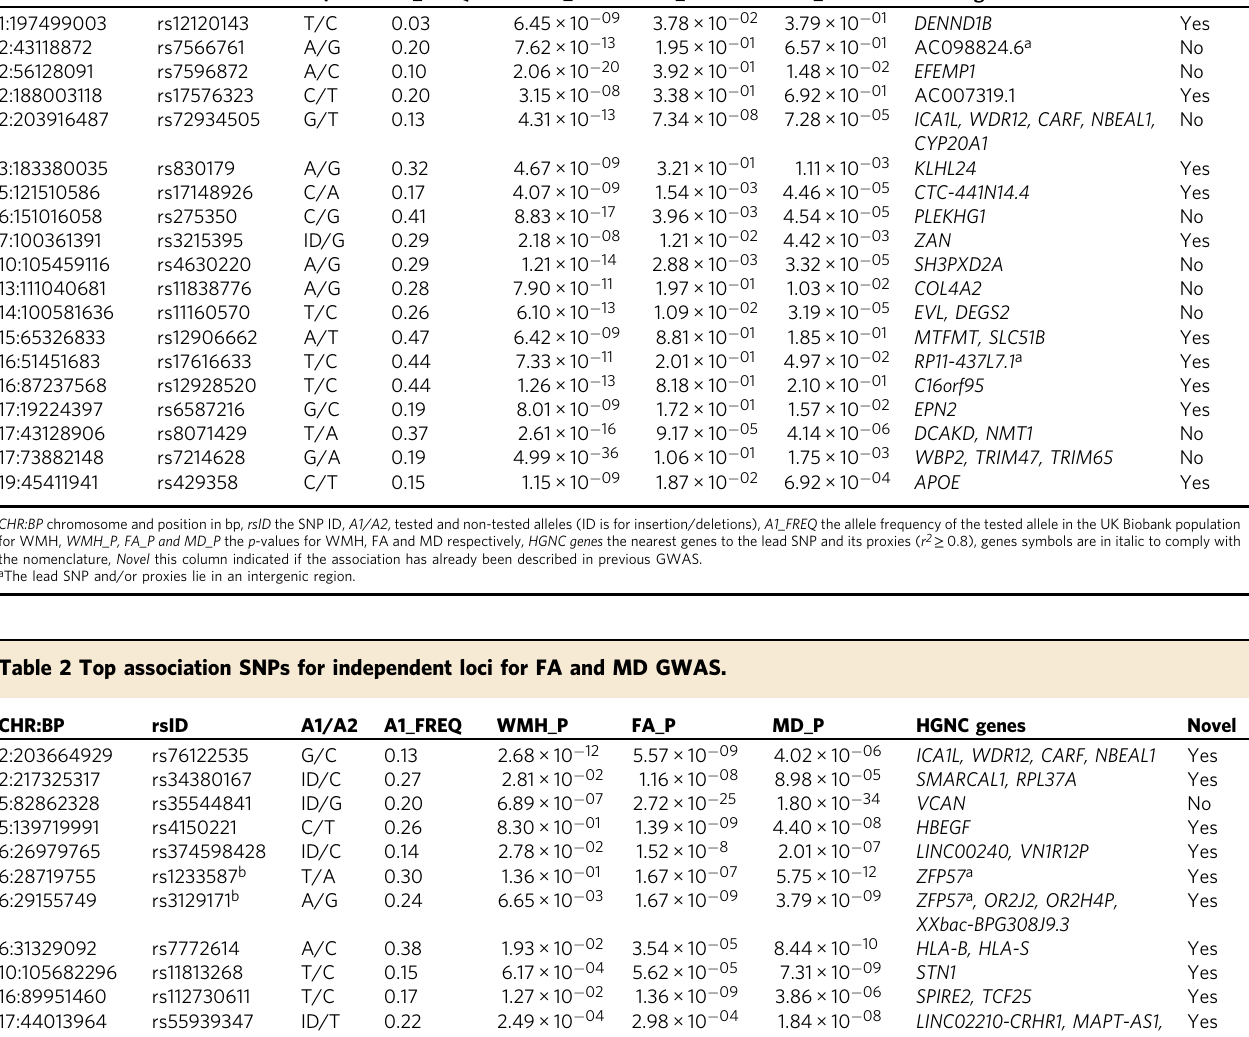
Table 1 Top association SNPs for independent loci for WMH meta-analysis. CHR:BP